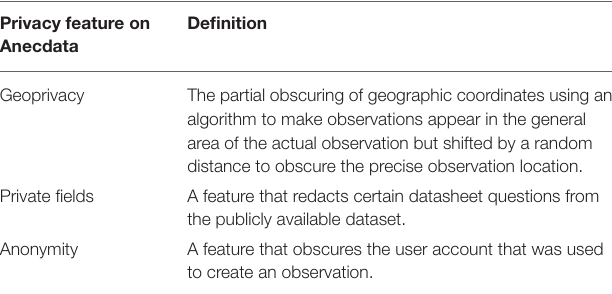
TABLE 1 | Definitions of privacy features on